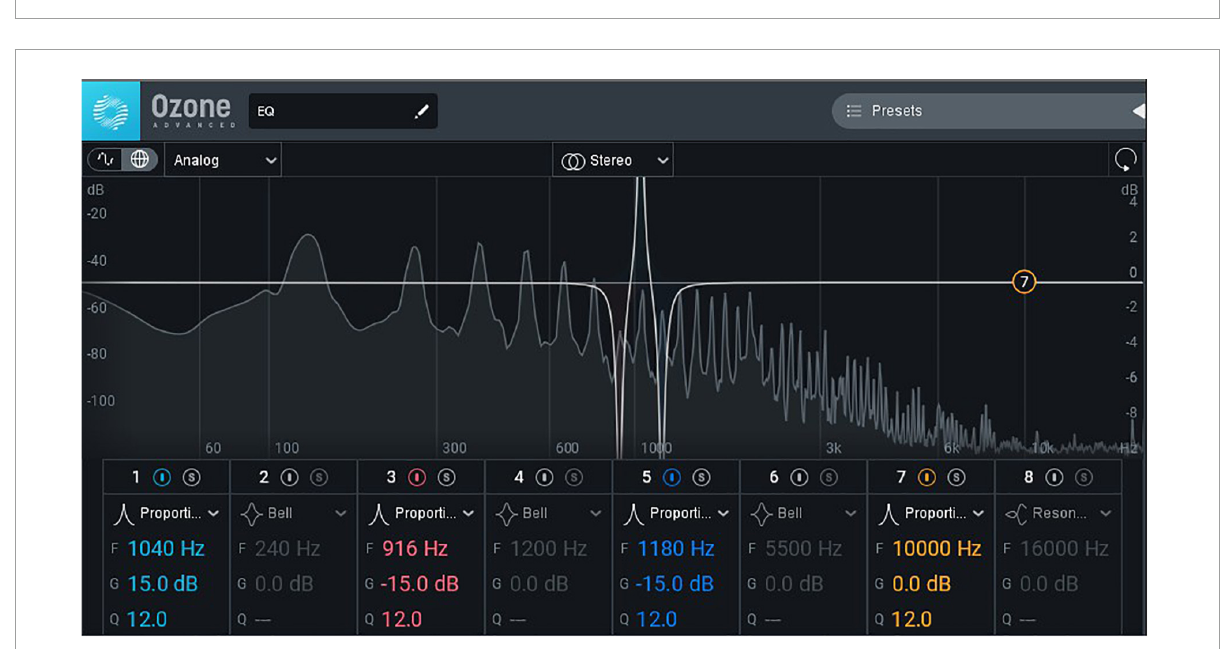
FIGURE2 Effect drawing of harmonic loudness adjustment. Image reproduced with permission from Ozone software. © 2022 IEEE. Reprinted with permission from Cai and Zhou